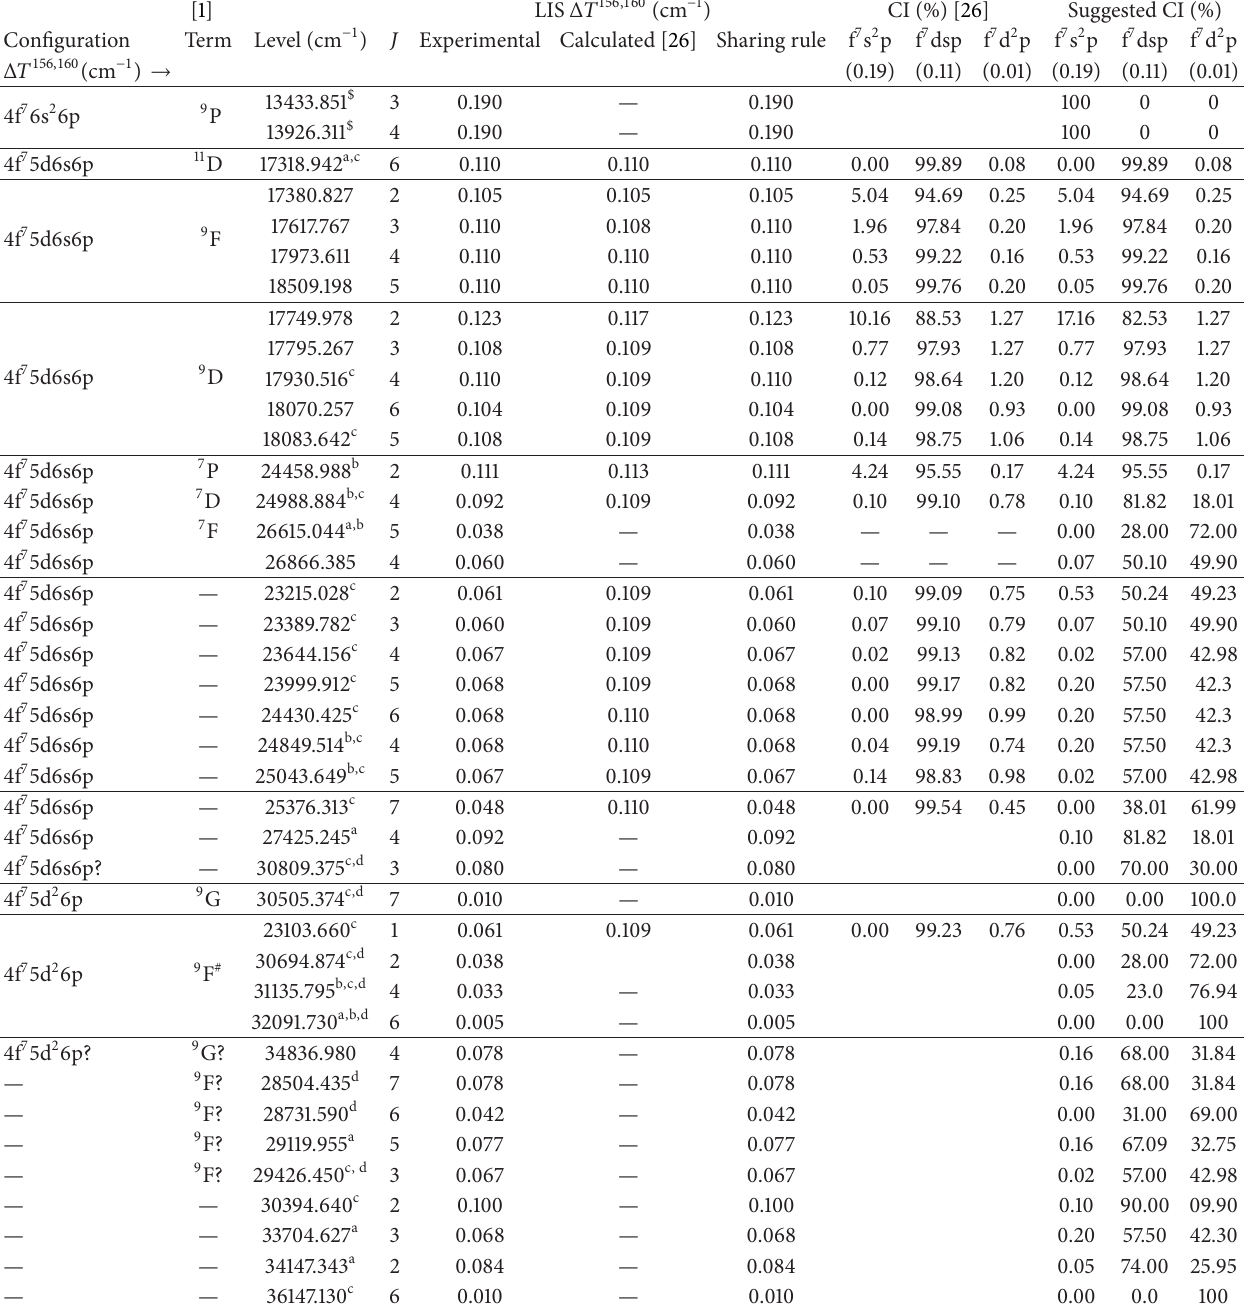
Table 4: List of even-parity energy levels with their experimental LIS Δ𝑇 156,160 (cm −1 ) values encountered in the present studies. Levels, their configuration, term, and 𝐽 values have been taken from [1]. [1] LIS Δ𝑇 156,160 (cm − 1 ) CI (%) [26] Suggested CI (%)